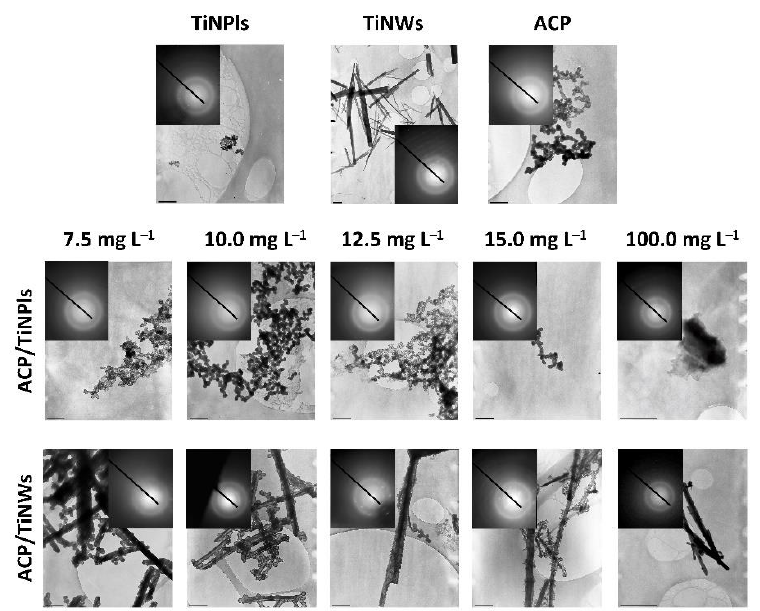
Figure 4. TEM micrographs of the TiO 2 nanoplates (TiNPls), nanowires (TiNWs), amorphous calcium phosphate (ACP) formed in the control system, and a precipitate formed in the presence of a different concentration of TiNPls (ACP/TiNPls) and TiNWs (ACP/TiNWs) after 15 min reaction time. c (CaCl 2 ) = c (Na 2 HPO 4 ) = 4 · 10 − 3 mol dm − 3 , pH init = 7.4, ϑ = (25.0 ± 0.1) ◦ C. The scale bar is 0.5 µ m, except in 100 mg L − 1 cases where the scale is 1 µ m.